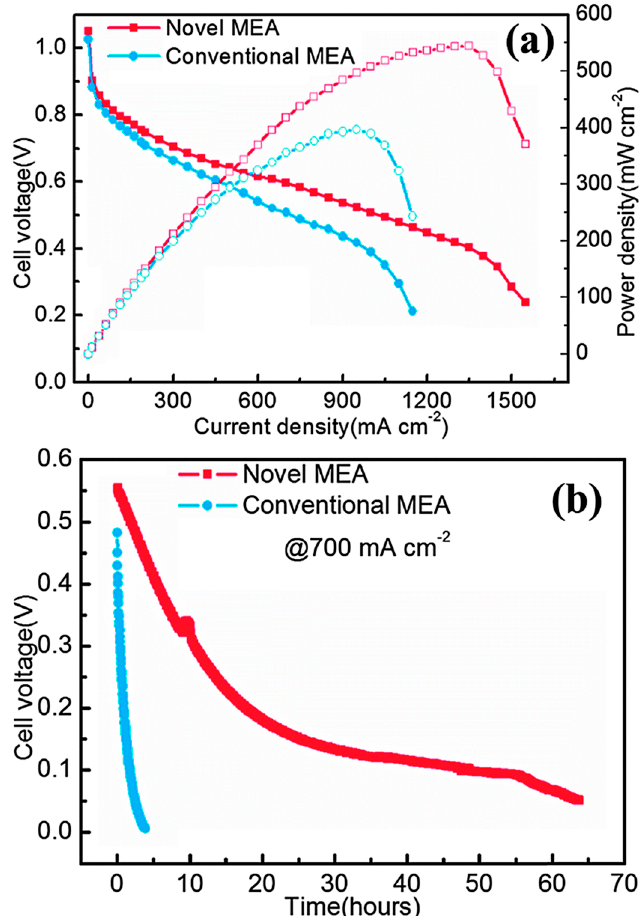
Figure 8. Comparison between conventional and novel MEAs. ( a ) Polarization and power–density curves; ( b ) constant current discharge curves (O 2 , current density 700 mA cm − 2 ). Reproduced from Ref. [77] with permission from The Royal Society of Chemistry.